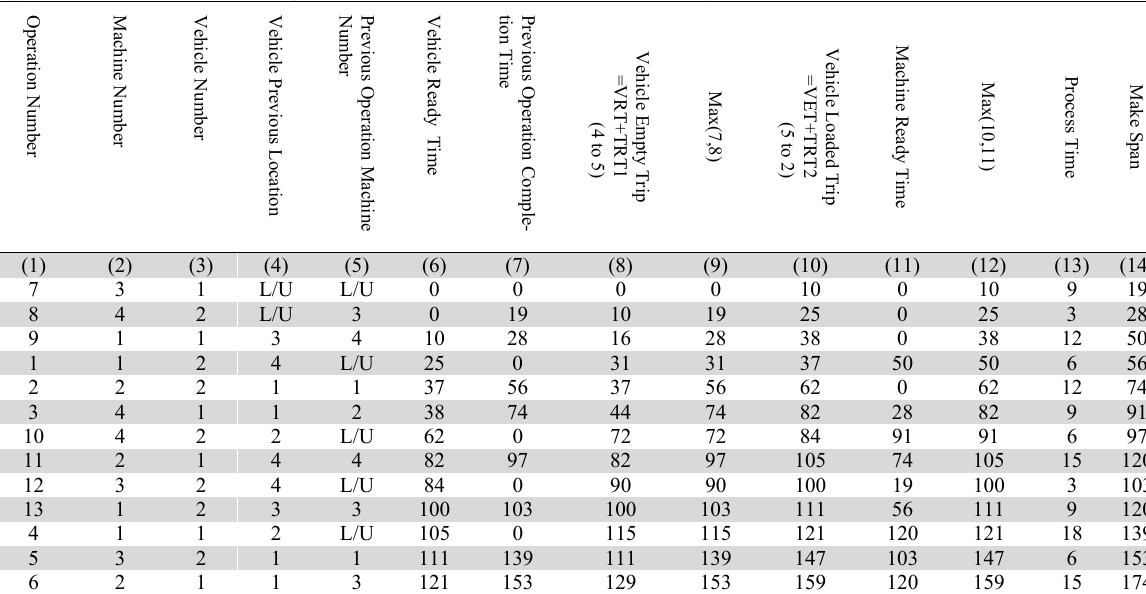
Operations schedule through FUZZY (for Problem set 5 and layout